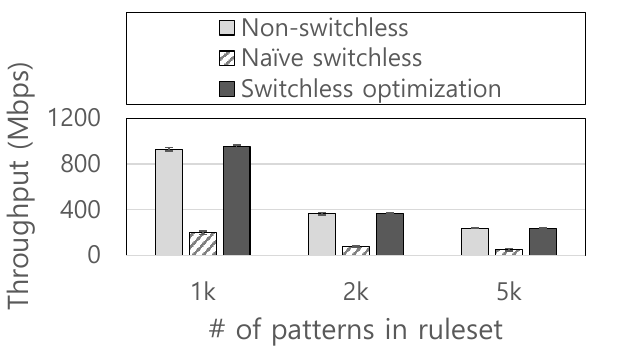
Figure 7. End-to-end pattern matching throughput while varying the number of ruleset